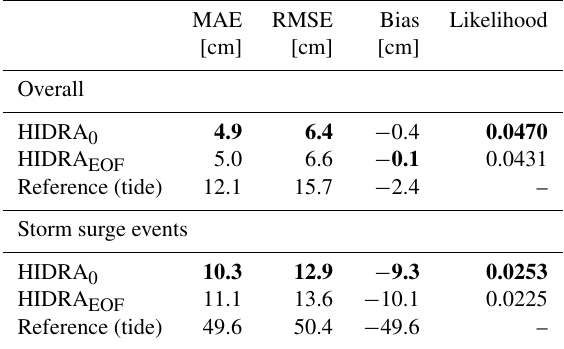
Table 4. Comparison of the proposed ASE-based HIDRA 0 and the EOF-based HIDRA EOF in terms of overall performance and perfor- mance on storm surges. The astronomic tide model performance is reported for reference. The best result in each category is denoted in bold.